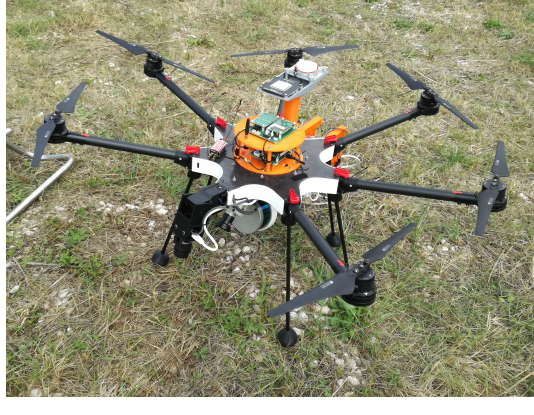
Figure 11. STORK